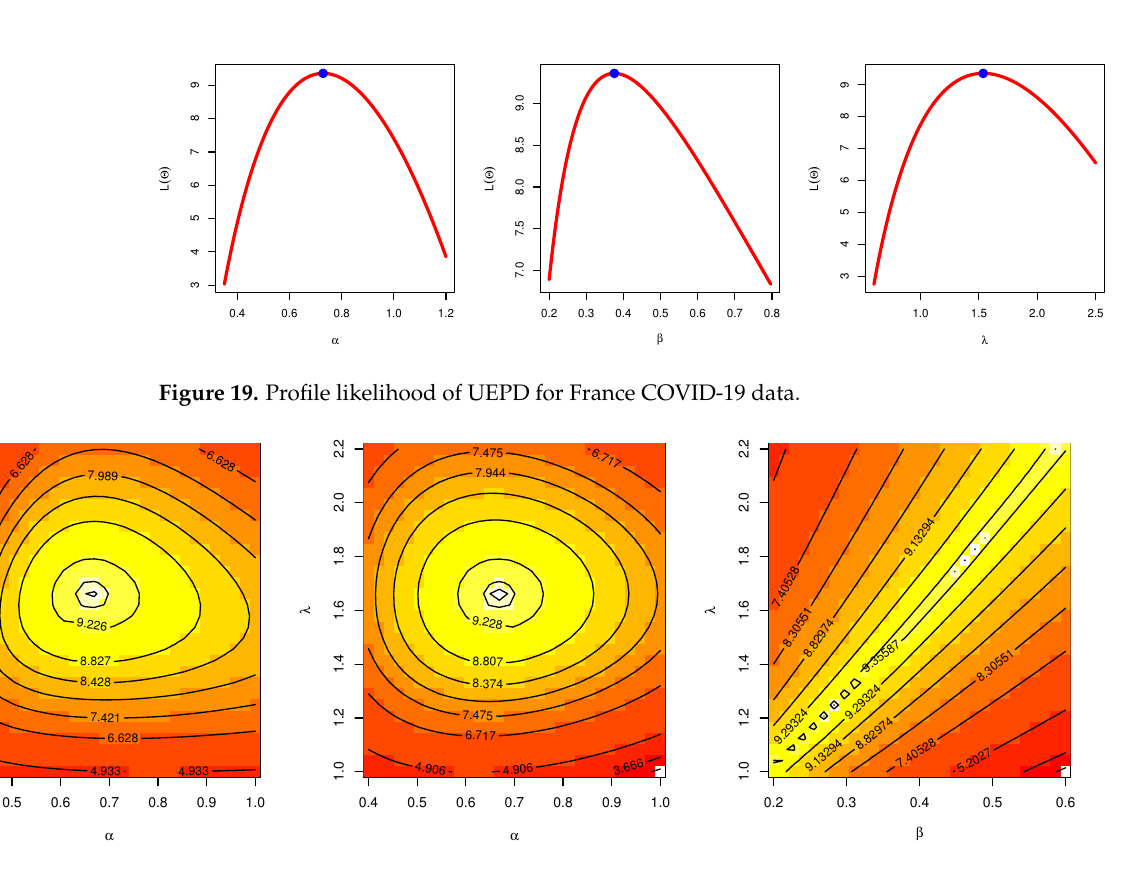
Figure 20. Contour plot of UEPD for France COVID-19 data.